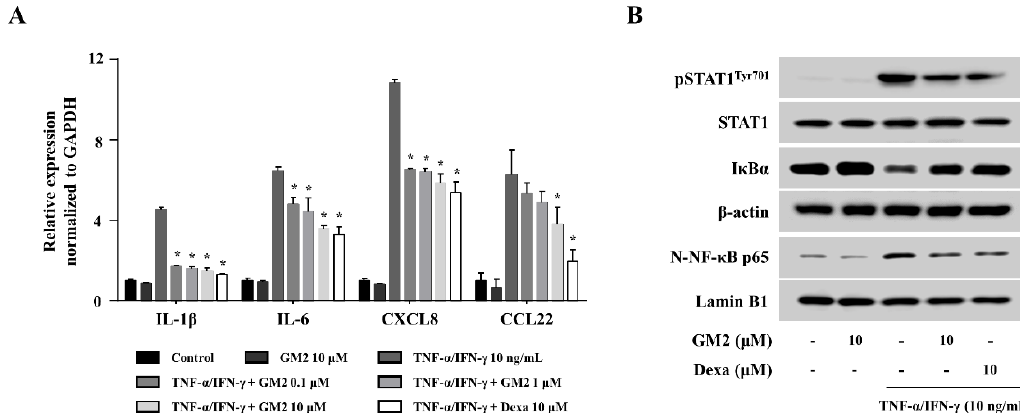
Figure 6. Effects of GM2 on keratinocyte activation. ( A ) Inflammatory cytokine gene expression was measured by qPCR. HaCaT cells (2 × 10 5 cells/24-well plates) were pretreated with or without GM2 or Dexa for 1 h and subsequently treated with TNF- α /IFN- γ for 6 h. ( B ) Western blot analysis was utilized to evaluate the activation of signaling proteins (p: phosphorylated; N: nuclear). For protein analysis, HaCaT cells (1 × 10 6 cells/6-well) were pretreated with or without GM2 or Dexa for 1 h and then treated with TNF- α /IFN- γ for 15 min. The STAT1, β -actin and lamin B1 band was used as a loading control. Data presented in the graph represents the means ± SEM ( n = 3). * p < 0.05, compared with the TNF- α /IFN- γ -stimulated group. Dexa: